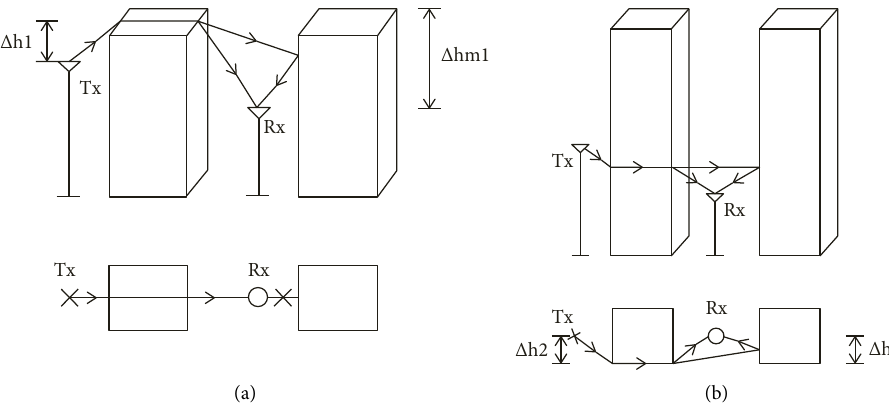
Figure 2: Mechanism of diffraction around the buildings. (a) Over rooftop. (b) Building corner.